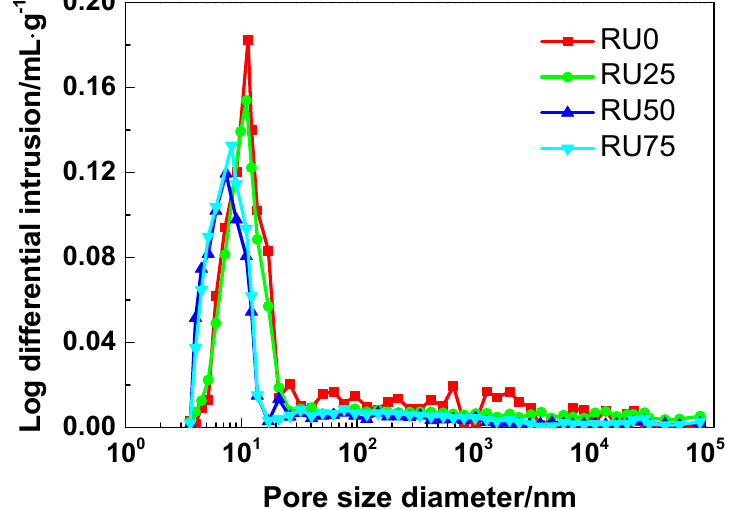
Figure 4. The pore-size distribution of RS-UHPC with different contents of GO.